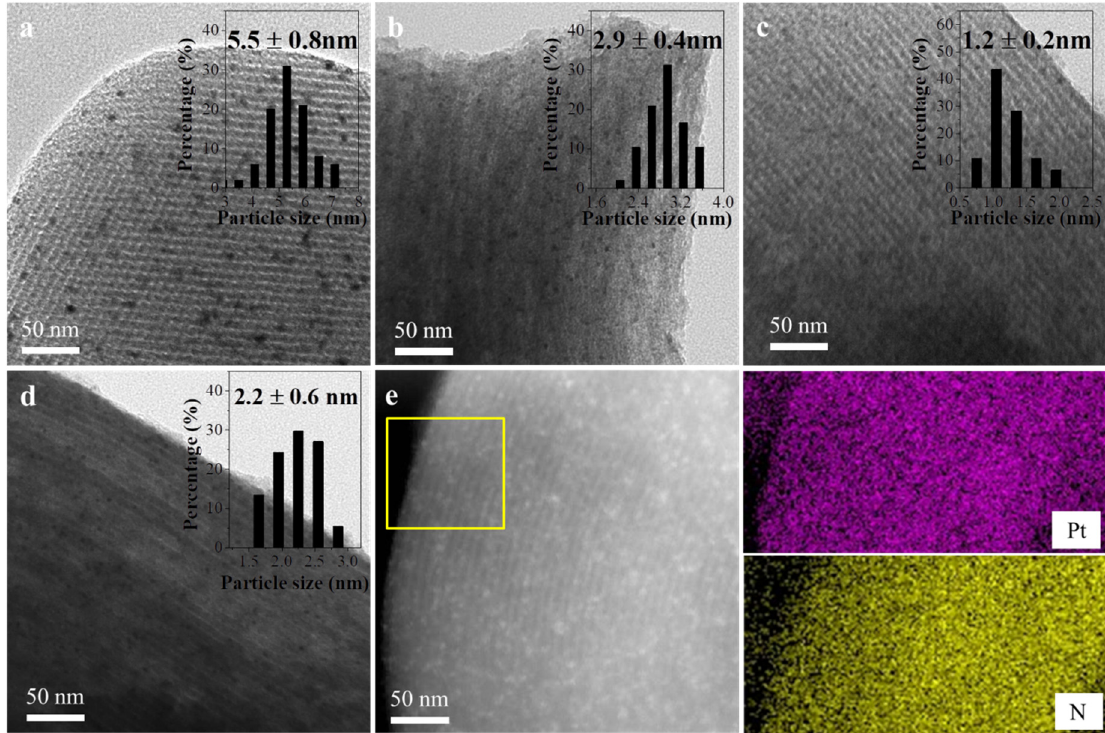
Figure 3. TEM images of ( a ) Pt / CMK-3, ( b ) Pt / N-CMK-3-1, ( c ) Pt / N-CMK-3-2, ( d ) Pt / N-CMK-3-3, and ( e ) high-angle annular dark-field scanning-transmission electron microscopy (HAADF-STEM) and elemental mapping images of Pt / N-CMK-3-2. The average diameters of the Pt particles were obtained by measuring about 200 clusters for each sample.